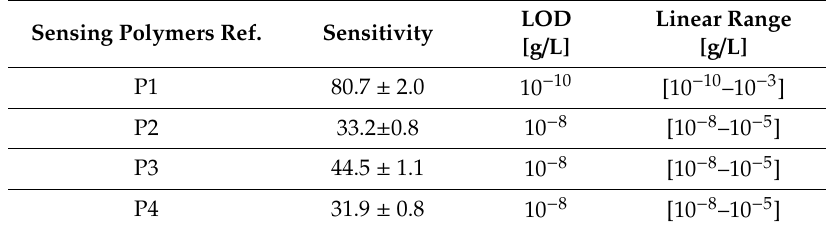
Table 2. Comparative study: responses of sensors based on P1–P4 polymers for the Pb 2+ ion. Sensing polymers Ref.